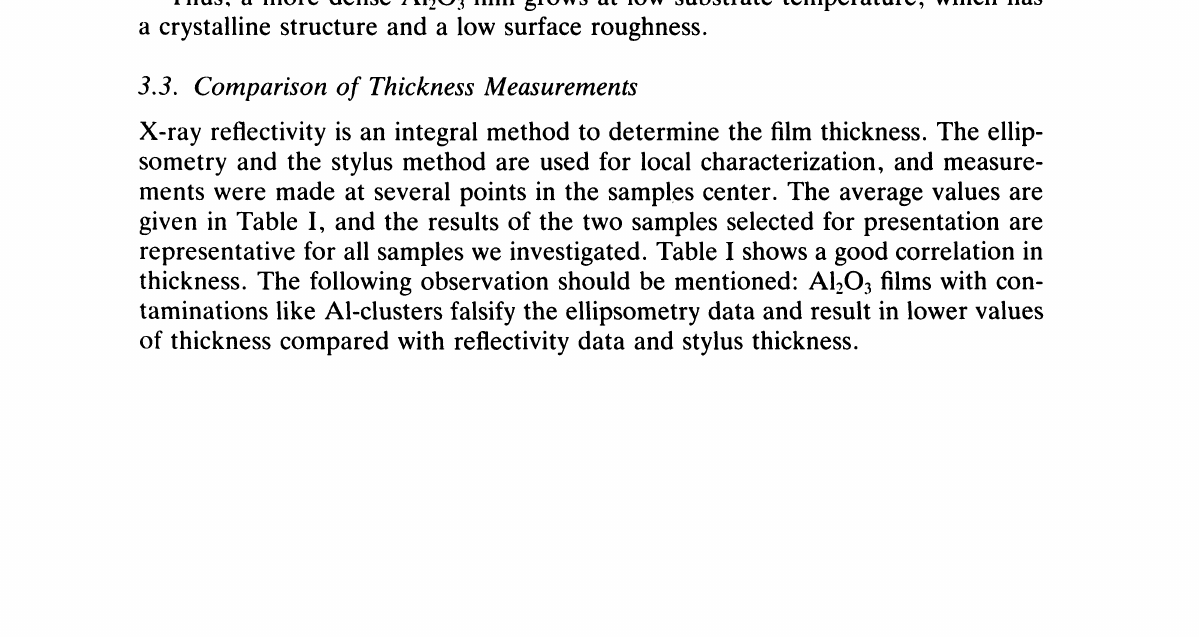
FIGURE 4 experimental and polished silicon